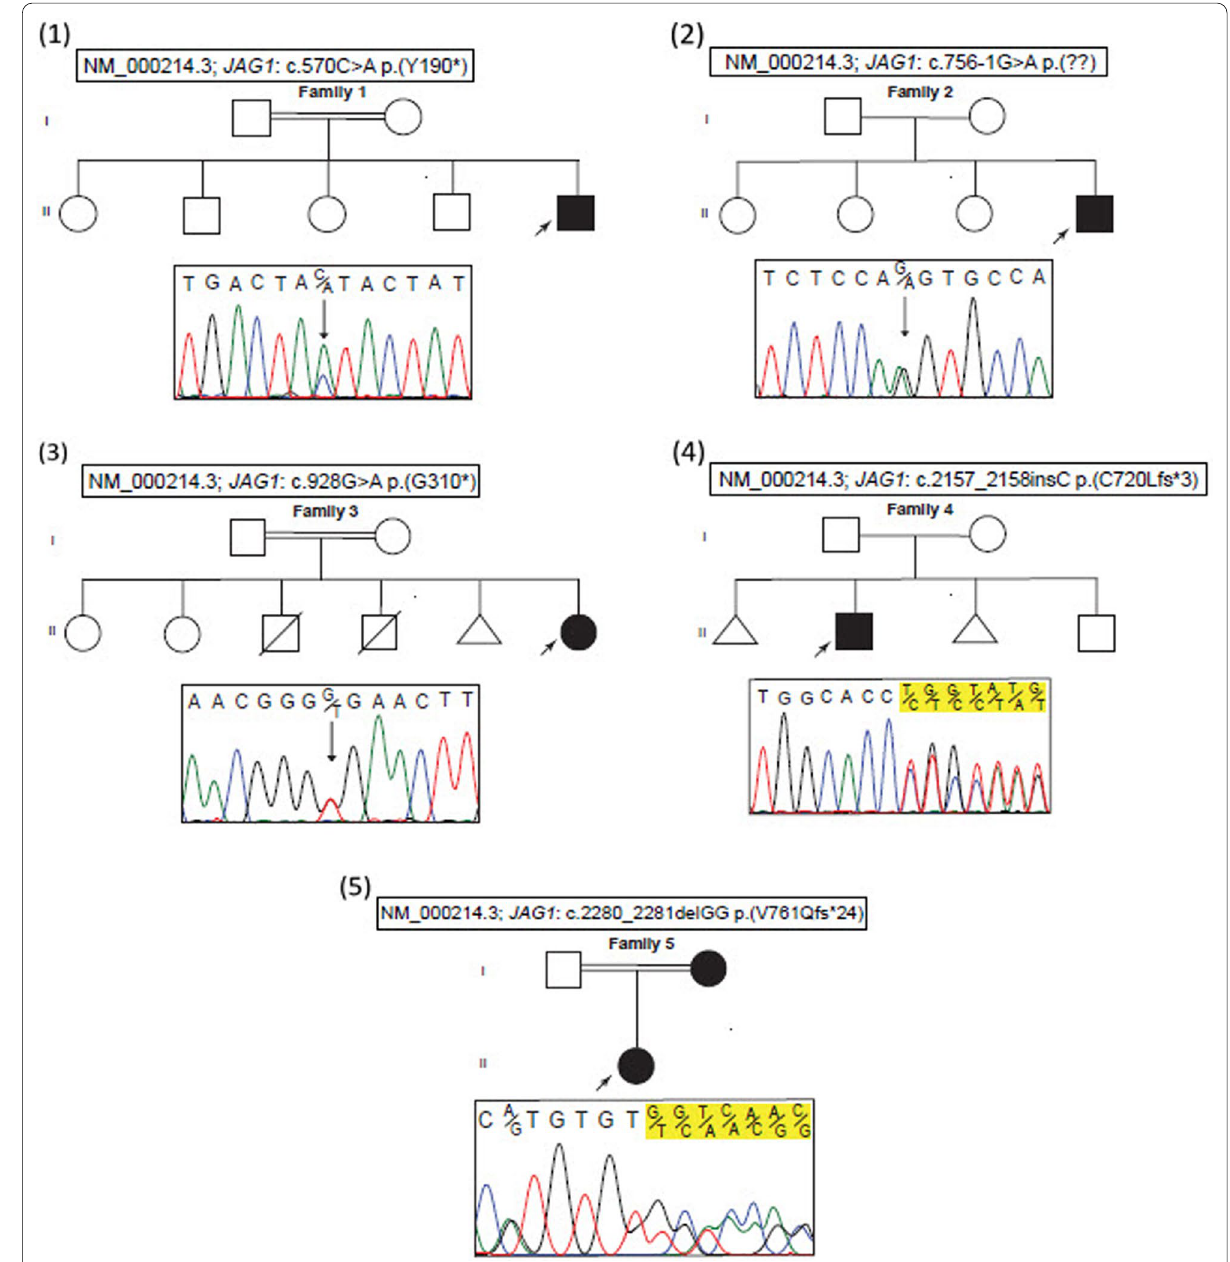
(1–5). The black arrow points to the detected variants in families 1 to 3. The highlighted sequences in sequencing chromatograms show